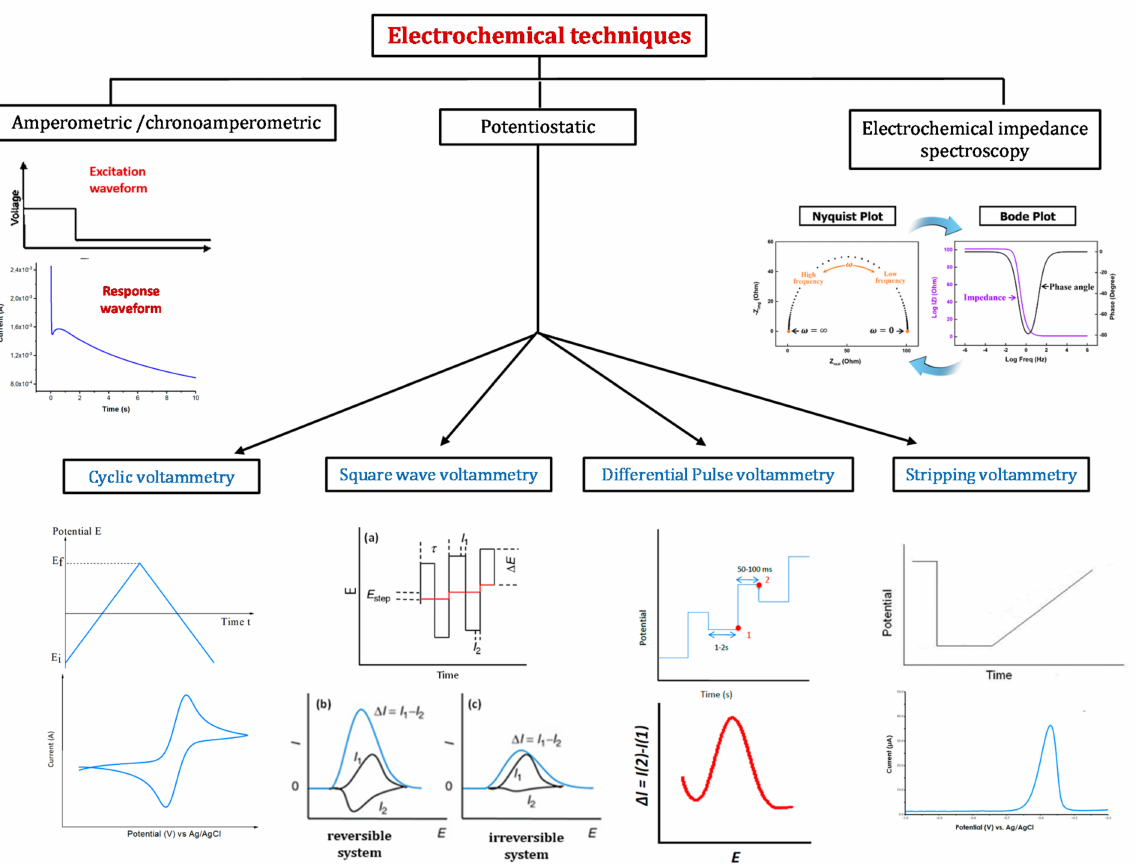
Figure 8. Schematic representation of the most common electrochemical techniques used in the detection of pollutants in water sources. ( a ) Details of the application of pulses in the square wave voltammetry technique and the corresponding voltammograms for reversible ( b ) and irreversible systems ( c